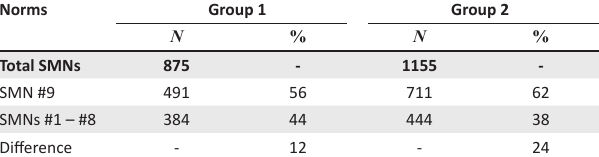
TABLE 4: Total number of sociomathematical norms compared to sociomathematical norm #9.